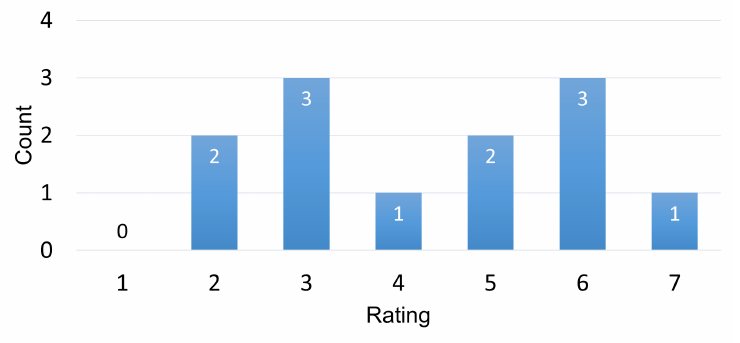
Figure 15. Answers for agreement to the statement related to H3 “The more distracting translations were during thinking, the more helpful the pausing was for me”. 1 = fully disagree, 7 = fully agree; n =